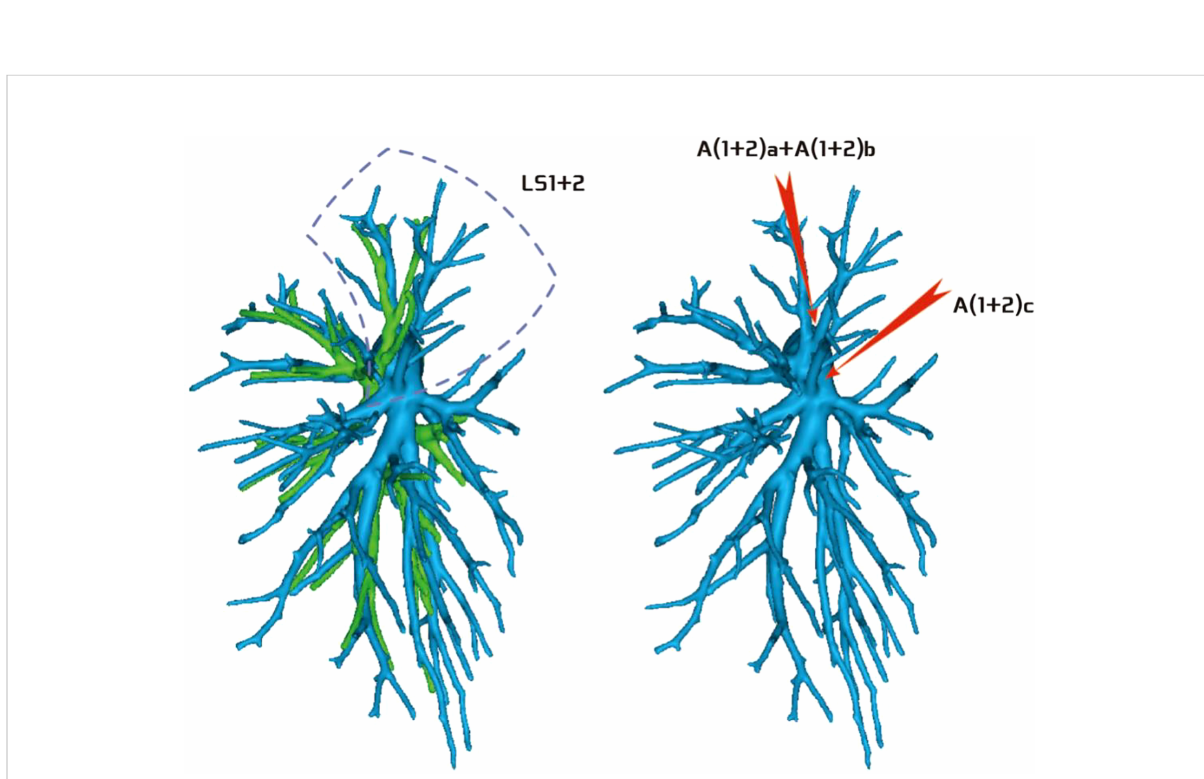
FIGURE 5 Type II: Dotted line is the LS1 + 2 area, A(1 + 2)a and A(1 + 2)b are co-trunks, and A(1 + 2)c is a single branch.